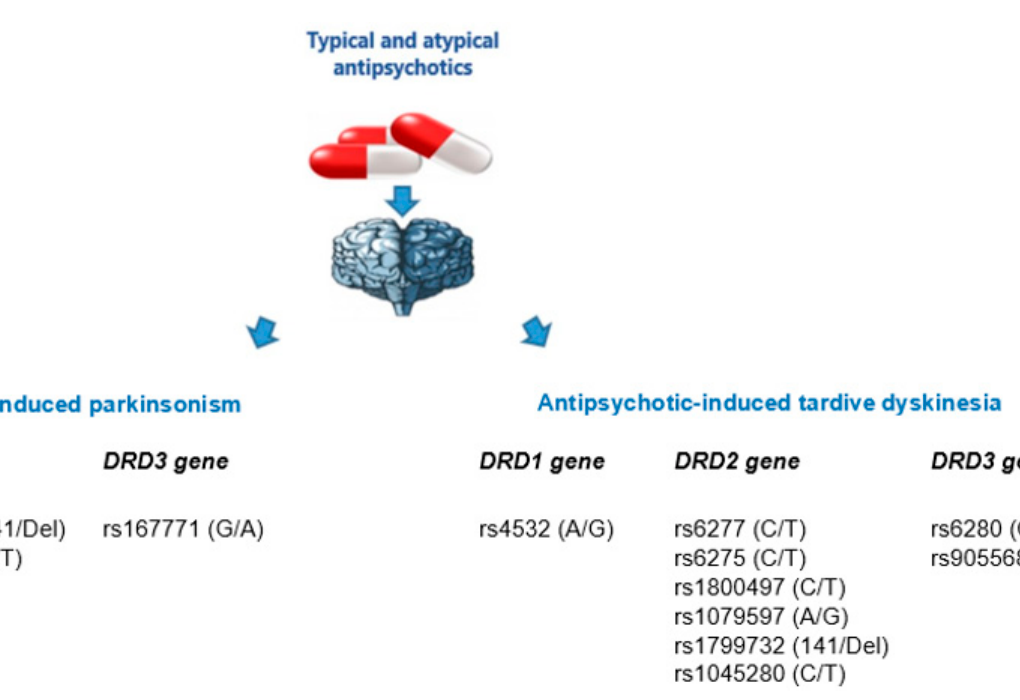
Figure 2. Positive associations of single nucleotide variants and polymorphisms of dopamine receptor genes with the risk of developing antipsychotic-induced parkinsonism and antipsychotic-induced tardive